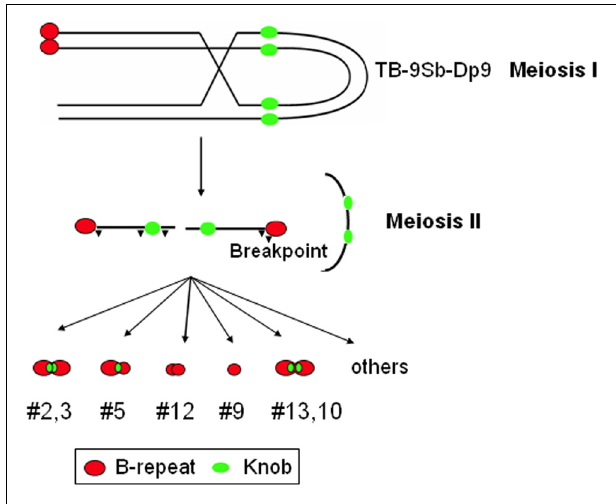
FIGURE 1 | Initiating the chromosome type BFB cycle to generate minichromosomes. A translocation between the B chromosome and the short arm of chromosome 9,TB-9Sb, was recombined with a reverse duplication of 9S to generateTB-9Sb-Dp9.This chromosome can recombine with itself as depicted which will join the sister centromeres. At meiosis II the sister centromeres will separate and create a chromatin bridge that will rupture.This broken chromosome will fuse, form a bridge, and break through the gametophyte generation but at the second pollen mitosis the B centromere will undergo non-disjunction.This will place two broken chromosomes in a sperm and thus following the subsequent fertilization event, these two broken chromosomes will set up the chromosome type of BFB cycle that will continue throughout development. Using this approach, Zheng etal. (1999) and Han etal. (2007) produced a collection of minichromosomes described in the text. B repeat is the B chromosome specific sequence present in and around the centromere of the B chromosome. Knob is the repeats of heterochromatin found on maize chromosomes including the short arm of chromosome